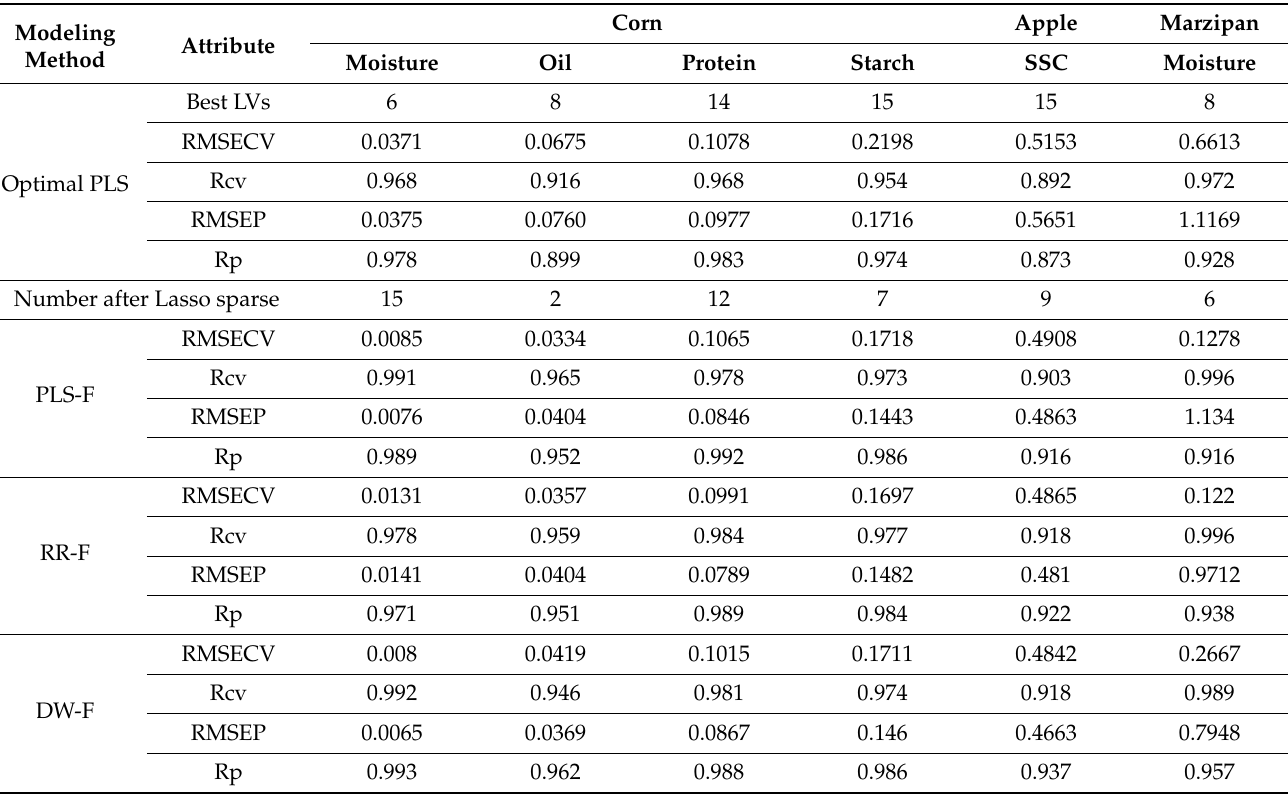
Table 2. Evaluation parameters for moisture, oil, protein, and starch of corn, organic matter of soil, and moisture of marzipan by PLS and three proposed fusion